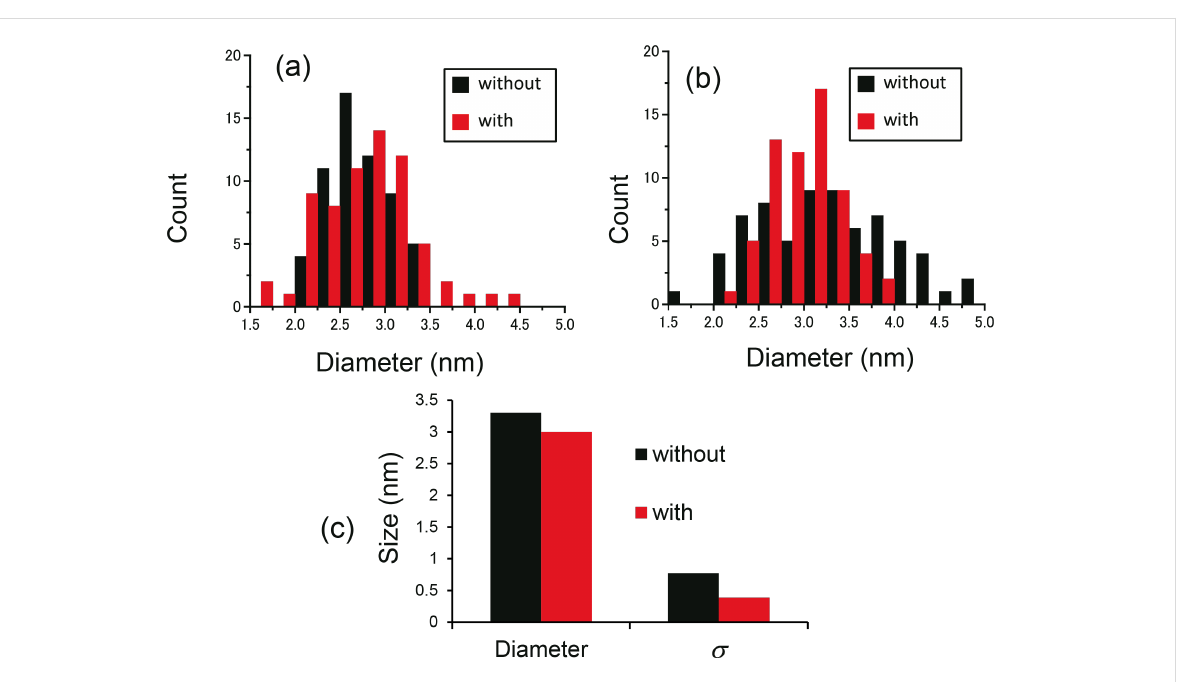
Figure 7: (a) Size distribution of among nanocrystals grown without and with 532 nm light (400 mW), t = 5 min. (b) Distribution of diameter among nanocrystals grown without and with 532 nm light (400 mW), t = 60 min. (c) Average diameter and σ .